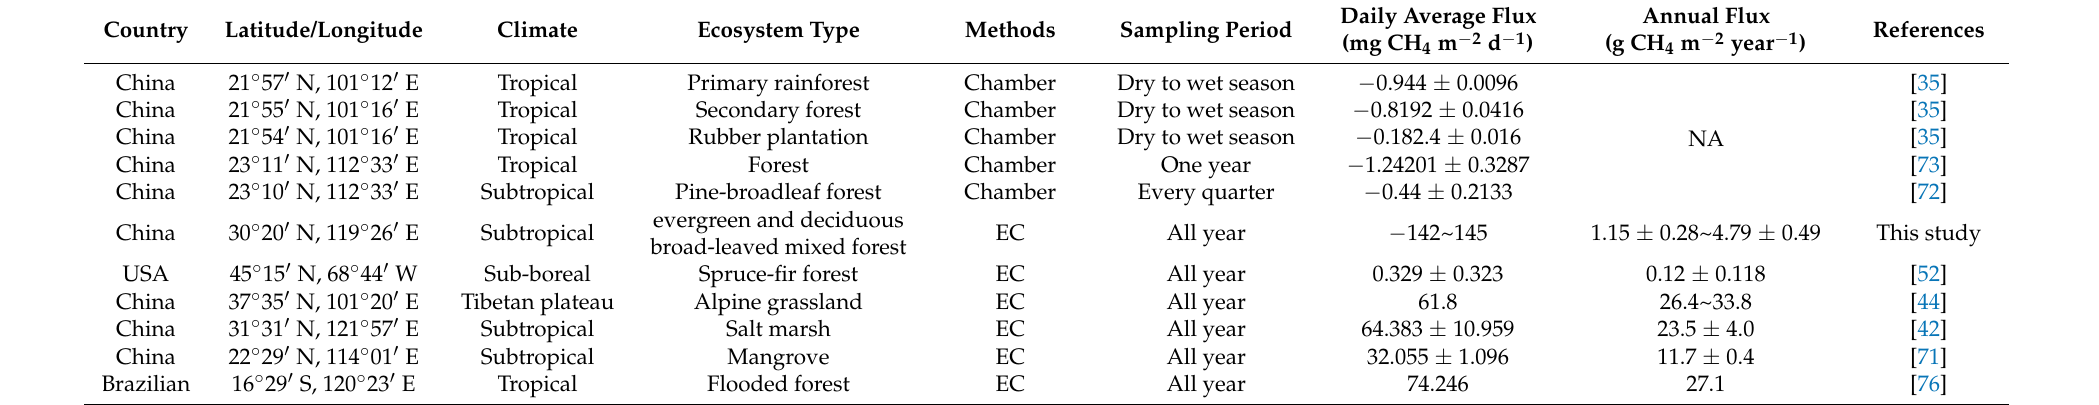
Table 1. Comparison of CH 4 budgets in different